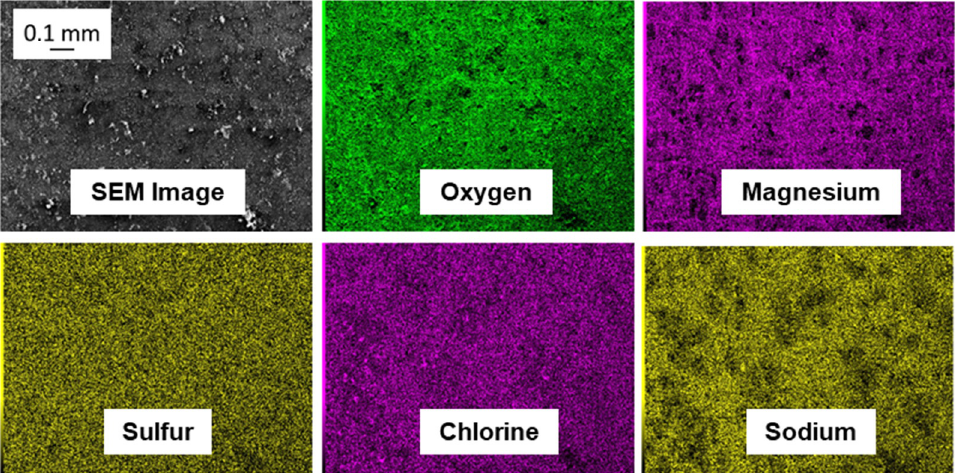
Figure 14. The SEM images and EDX maps of a bare steel coupon that was continually galvanically coupled to a coated specimen.